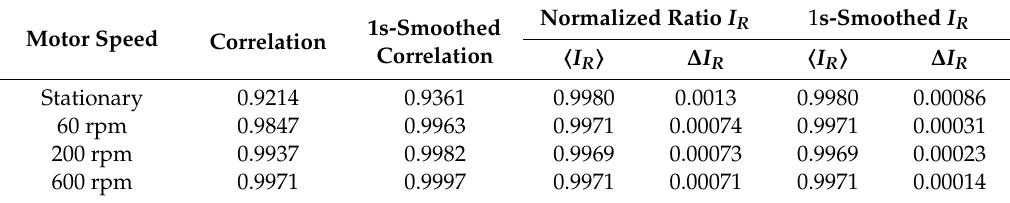
Figure 13. Intensity time-series for different wavelength separations; ( a ) intensity of on and off wavelengths separated by 16 GHz; ( b ) intensity of on and off wavelengths separated by 36.4 GHz; ( c )